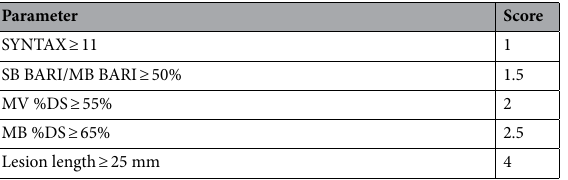
Table 3. Bifurcation functional significance score (BFSS). Bifurcation Functional Significance Score (BFSS). Abbreviations same as Table 2. SB/MB BARI score—ratio of SBBARI score divided by MBBARI score.